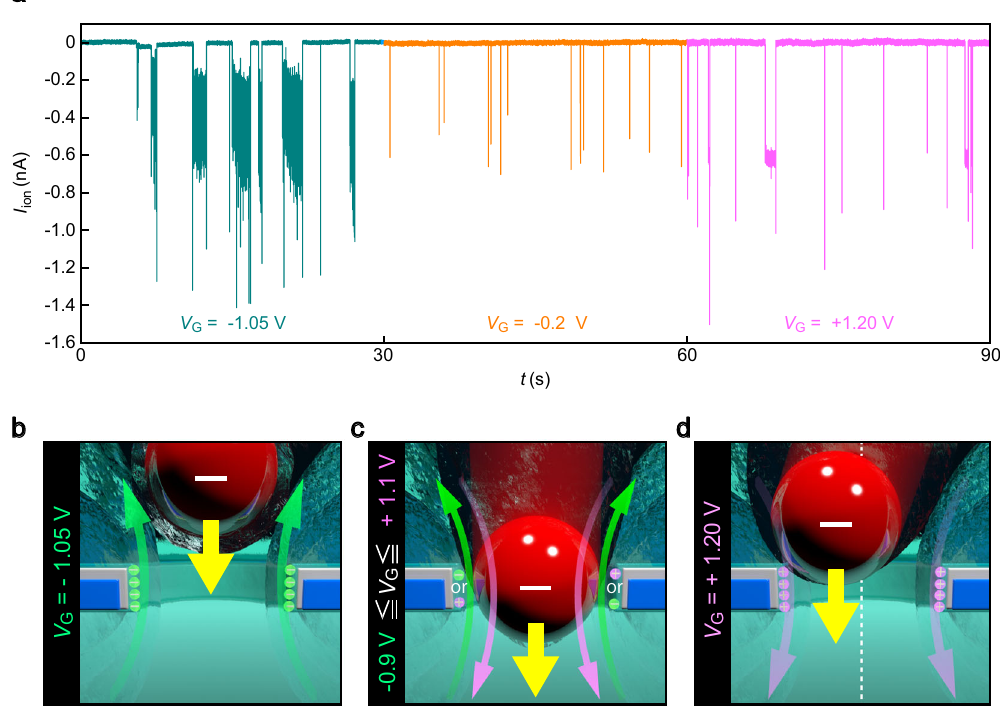
Fig. 3 Gate-dependent modes of single-nanoparticle dynamics. a Typical I ion traces observed for 200 nm-sized nanoparticles in the three different V G regimes under V b = 0.5 V (orange: V G = − 0.20 V (I); pink: V G = + 1.20 V (II); cyan: V G = − 1.05 V(III)). The open pore current is offset to zero. Schematic explanations of the underlying mechanism. Green and pink balls describe, respectively, negative and positive electrical potentials induced at the SiO 2 wall surface by the gating. Under large negative V G , the strong electroosmotic fl ow in direction opposite to the electrophoresis of the negatively-charged nanoparticles retard the translocation speed ( b ). When V G is small, the electroosmotic fl ow becomes too weak to cause any notable in fl uence on the electrophoretically-driven fast translocation motions of the particles irrespective of the voltage polarity ( c ). In case of large positive gate voltage conditions, the strong columbic interaction tends to temporarily trap the nanobeads when they come across the nanopore wall by the height ( I norm ) and utilized as a reference to convert the experimental resistive pulses (Fig. 5b) into z versus t traces. For instance, the motion track elucidated the nanoparticles being adsorbed at 130 nm above the pore center under V G = + 1.20 V (Fig. 5c inset). In addition, the subsequent drop in the ionic current at around t = 0.38 s (Fig. 5b inset) suggested electro- phoretic transits of the particles after desorption.